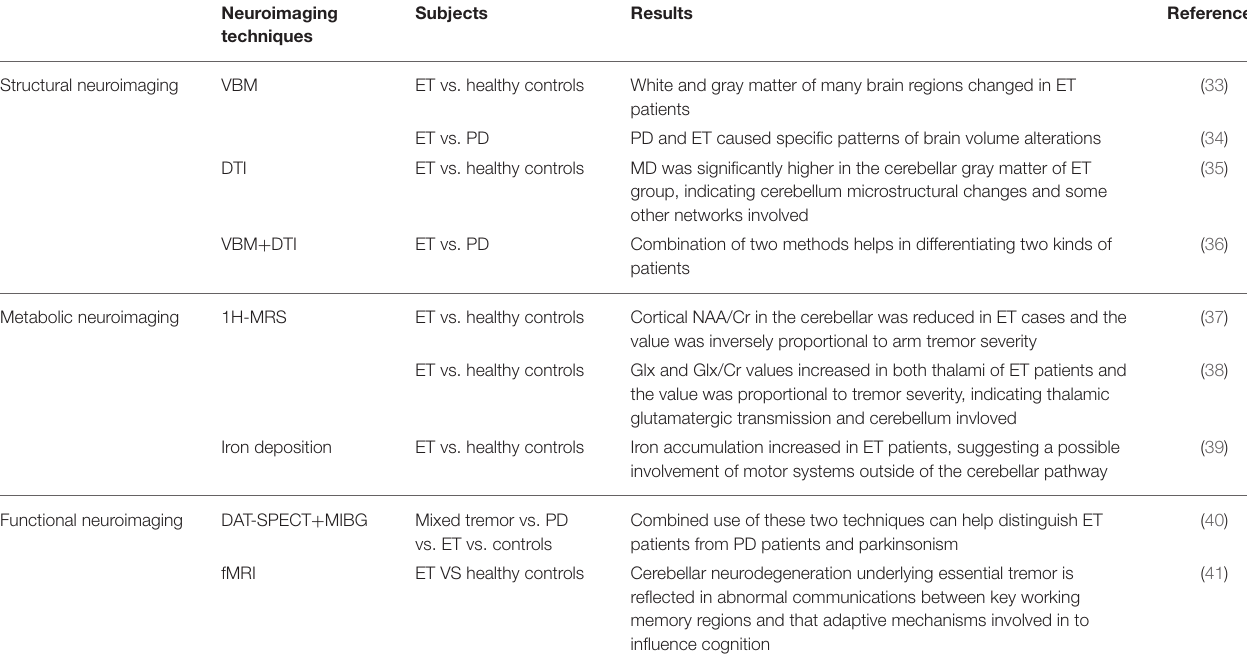
TABLE 2 | Studies on other neuroimaging about prodromal markers of new-onset PD in ET patients.